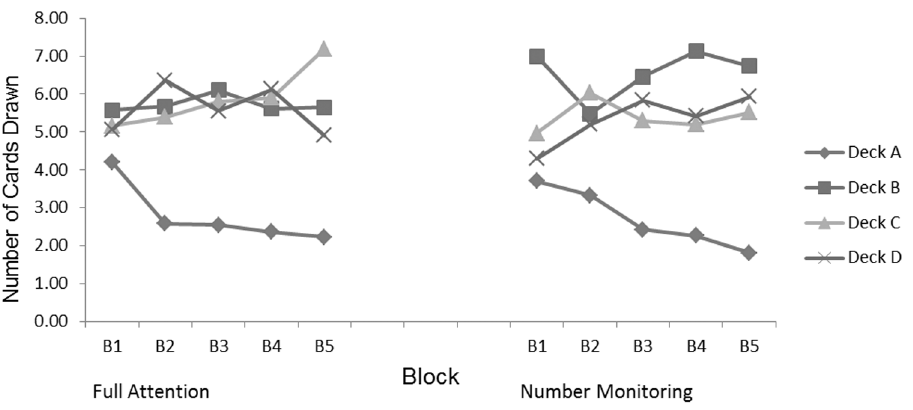
Figure 4. Draws per deck across